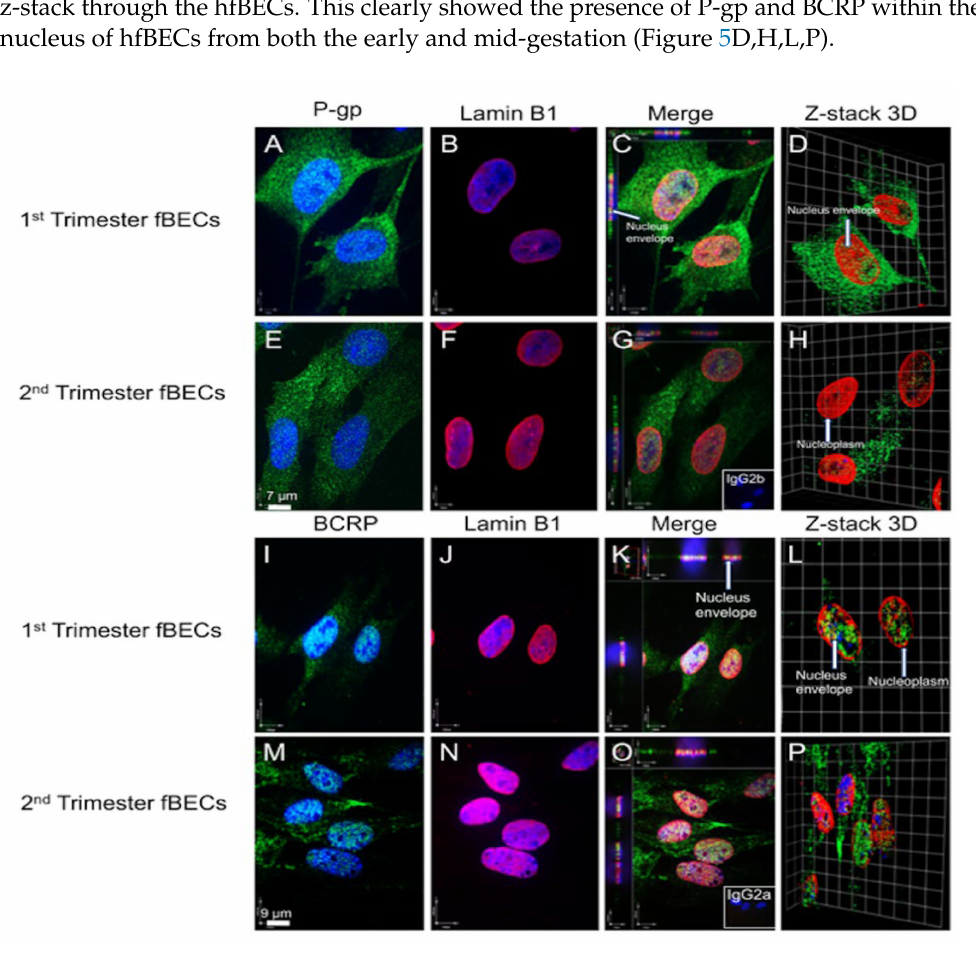
Figure 5. Expression of P-glycoprotein (P-gp) and breast cancer resistance protein (BCRP) in early and mid-gestation primary human fetal brain endothelial cells (hfBECs) . Represen- tative immunofluorescence images of P-gp ( A , E ) and BCRP ( I , M ) subcellular localization in early ( A – D , I – L ) and mid-gestation ( E – H , M – P ) hfBECs. Arrows show P-gp and BCRP staining within nuclear compartments. Lamin B1 staining (red) is used as a nuclear membrane marker. P-gp and BCRP (green) and lamin B1 staining co-localize inside the nucleus. Insets (bottom right) in ( G ) represent the isotype control IgG2b and ( O ) the isotype control IgG2a. ( D , H ) Z-stack 3D images of P-gp and Lamin B1 localization and ( L , P ) Z-stack 3D images of BCRP and Lamin B1 localiza- tion to the nucleus in hfBECs. Sections were counter-stained with DAPI (blue; a nuclear marker). n = 3/gestational age (representative images presented). Scale bars = 7 um (P-gp); = 9 µ m